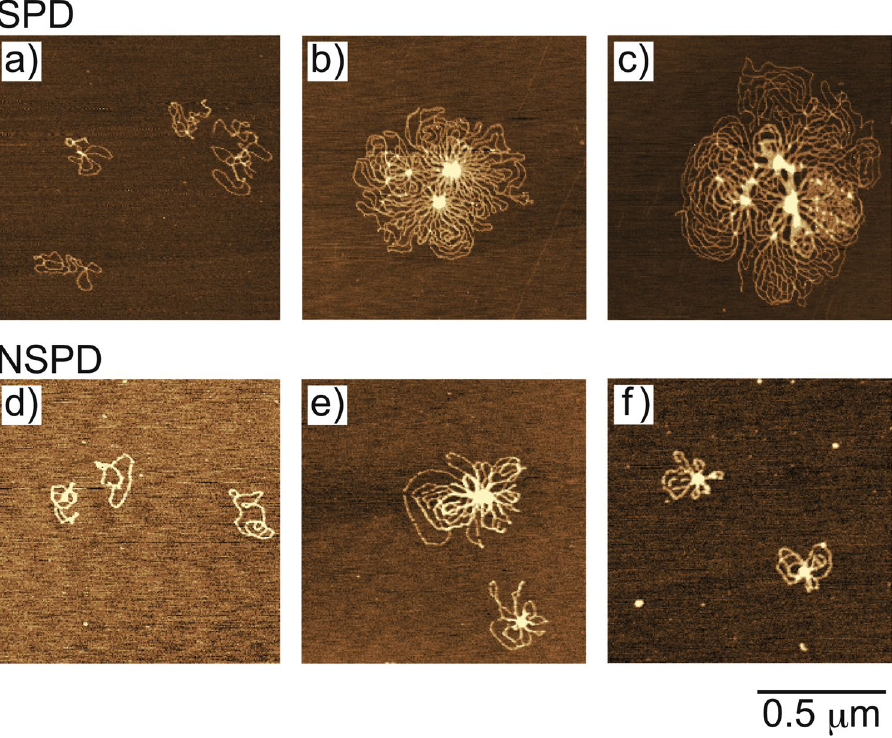
Figure 2. AFM images of plasmid DNA (4331 bp) in the presence of SPD and NSPD. Polyamine concentrations were ( a , d ) 0.1 mM, ( b , e ) 0.5 mM, and ( c , f ) 1 mM. The DNA concentration was 0.3 μ M in nucleotide